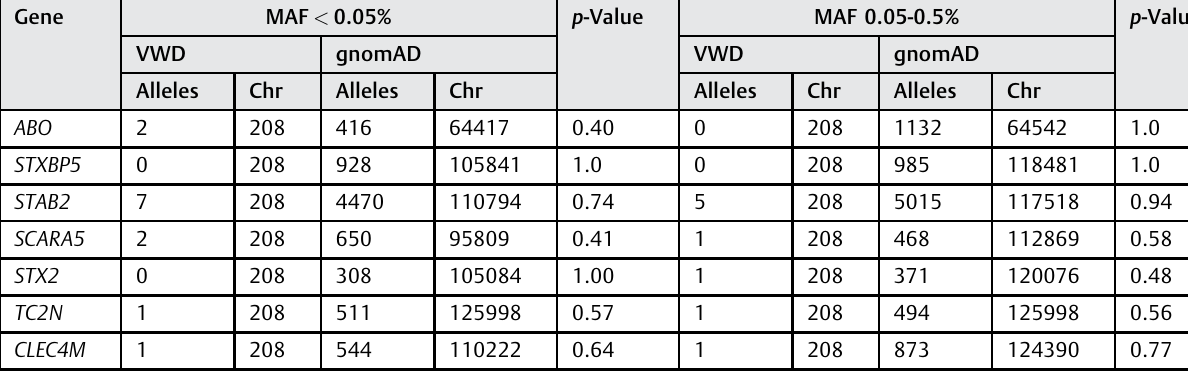
Table 4 Fisher ’ s exact test for accumulation of low frequency and rare variant alleles by comparison between VWD and the non- Finnish European gnomAD